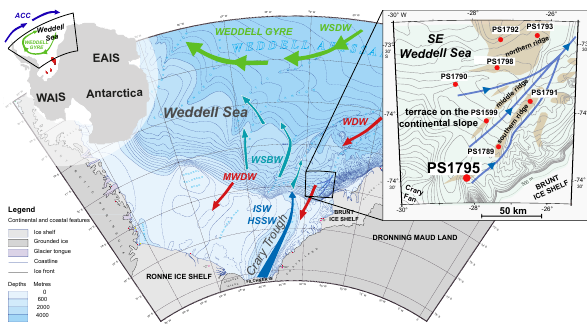
Fig. 1. Left shows overview map showing whole Antarctica with the West (WAIS) and East (EAIS) Antarctic Ice Sheets as well as the Antarctic Peninsula. The Weddell Sea (black square) is located in the southernmost part of Atlantic sector of the Southern Ocean. Additionally, the clockwise flowing Antarctic Circumpolar Current (ACC) and the Weddell Gyre (green arrows) are highlighted. The map in the centre shows a bathymetric chart of the Weddell Sea (Alfred Wegener Institute for Polar and Marine Research BCWS 1: 3 000 000; Bremerhaven, 1997). Present-day flow direction of important water masses, i.e. High Salinity Shelf Water (HSSW), Ice Shelf Water (ISW), Weddell Sea Bottom Water (WSBW), Warm Deep Water (WDW) and the through heat loss Modified WDW (MWDW) are also indicated (further information see section 2.2). The core site area (black box) is located in the southeastern Weddell Sea close to the Brunt Ice Shelf. The small map on the right is a bathymetric map focussing on the southeastern Weddell Sea modified after (Weber et al., 1994), highlighting the Polarstern (PS) core sites referred to in this study (red dots). The core sites are located on ridges on a terrace of the continental slope. Southeast of each ridge (brown colour) runs a channel. During the LGM the thermohaline current (blue lines) was flowing towards the NE in the channels. Due to the Coriolis force most of the transported sediment is deposited NW of each channel.